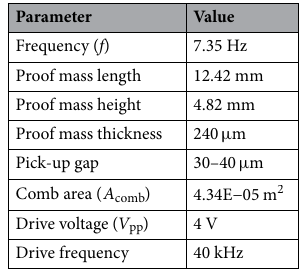
Table 1. Device parameters of the MEMS